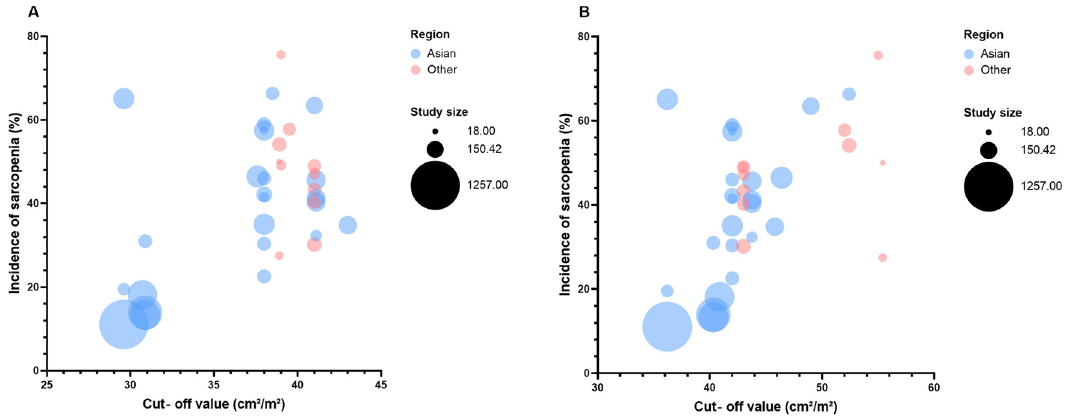
Figure 2. A bubble plot showing the cut-off values of